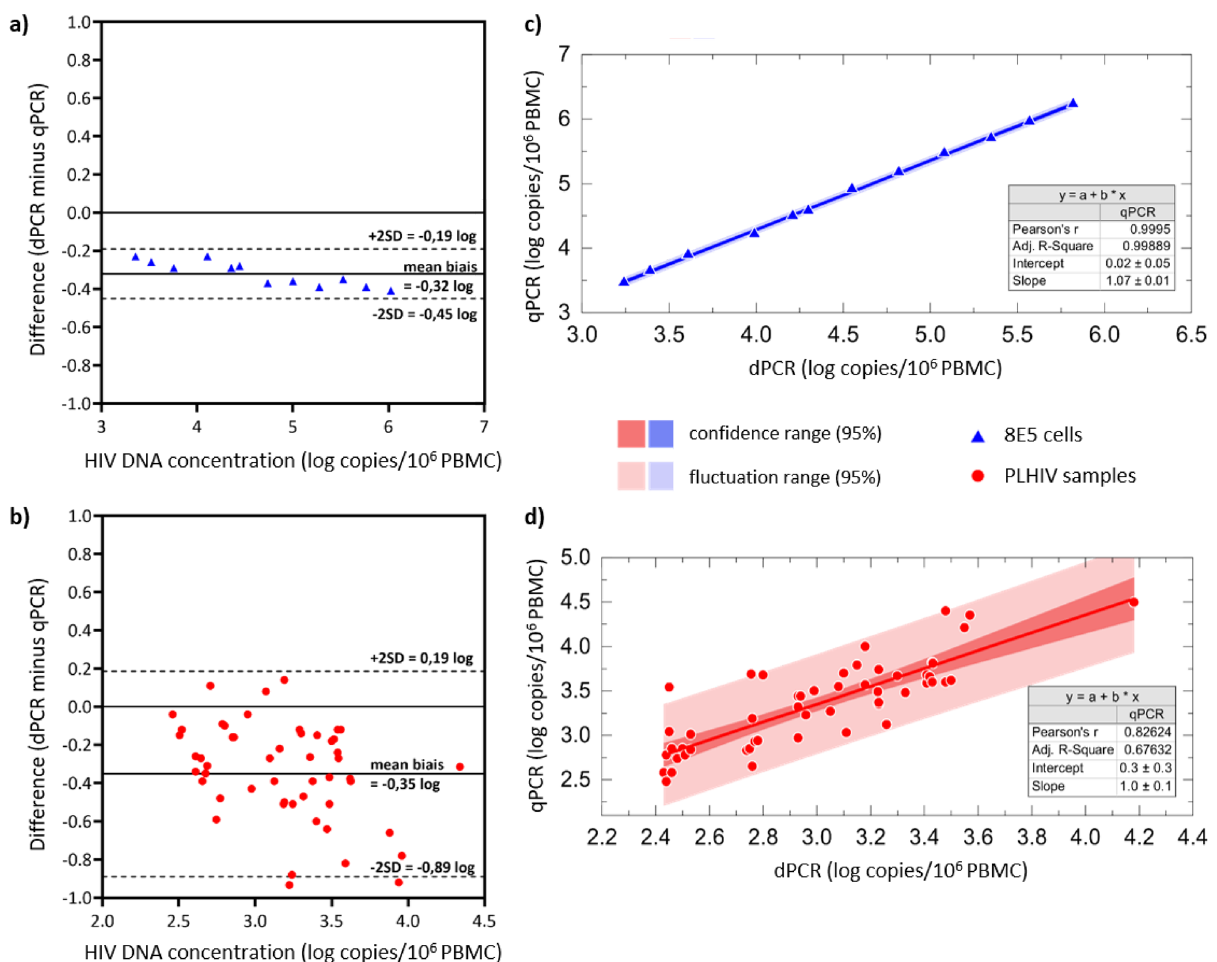
Figure 5. Comparison study between the dPCR and the qPCR. Bland–Altman dPCR minus qPCR was performed for ( a ) 12 samples of 8E5 cells, ( b ) 52 samples of PLHIV. Calculation of the correlation coefficient between the quantification values obtained with the qPCR and the qPCR for ( c ) 8E5 cells samples and ( d ) PLHIV